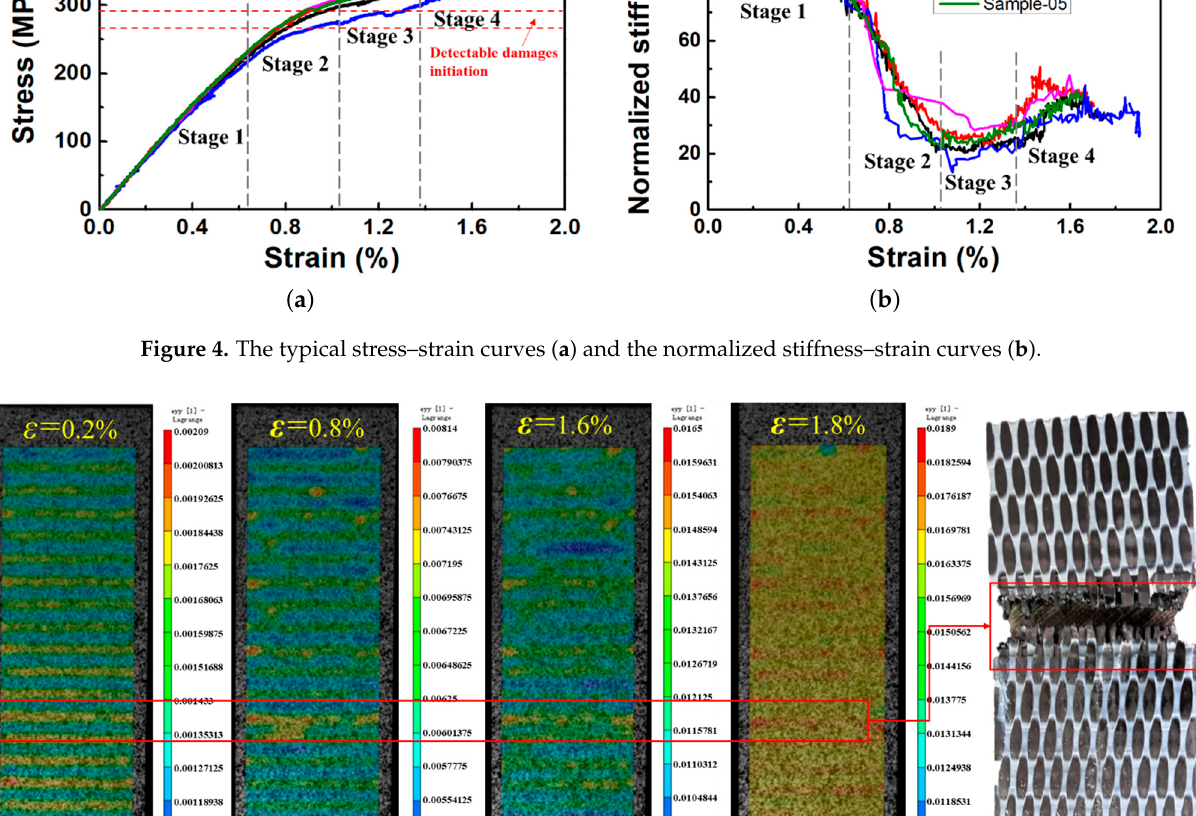
Figure 6. The tensile fracture morphology: the front view ( a ) and the inner left view ( b ). 3.1.2. AE Monitoring and Damage Mechanisms Evolution The main features of the AE signal consist of amplitude, rise time, counts, duration, energy, etc. [25]. According to previous studies, AE energy, AE counts, AE events and the cumulative values of the aforementioned three parameters are the main employed fea- tures to detect damage initiation and to characterize the evolution process. J.A. Pascoe utilized AE events as the initiation criterion and the first identified AE event was consid- ered as the moment of the damage initiation [39]. Fotouhi M and Oskouei AR used the first high-energy and high-counts AE signal as the criterion for damage initiation [40,41]. The cumulative AE energy, cumulative AE events and cumulative AE counts have also been used as the damage initiation criterion, with the first significant increase in these cumulative curves being considered as the damage initiation moment [42–44]. In this study, the real-time high-energy AE monitoring was used as the damage initiation crite- rion and to record the damage process in the tensile tests. Figure 7 shows the recorded typical AE energy distribution during the tensile tests in contrast with the load curve. One can observe that the AE signal shows a random be- havior, while the load curve indicates a bilinear characteristic with an inflection point oc- curring at almost central time, during the test. The first high-energy AE signal occurred during the linear stage, which means that some relatively severe damages were brought